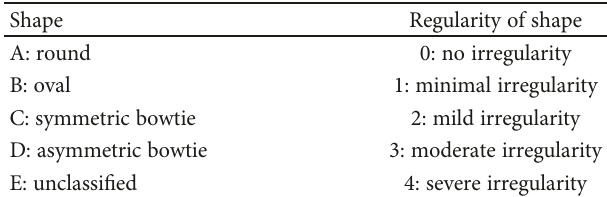
Table 1: Grading of topographic pattern.